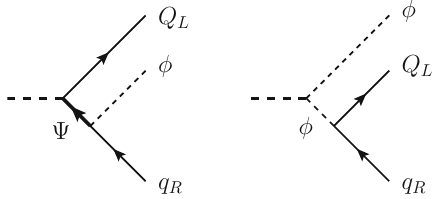
Fig. 1 Tree-leveldiagramsgivingrisetotheeffectiveLagrangians(11) [left] and (12) [right]. Thick lines denote S and the VLQs, whereas the thin lines represent SM